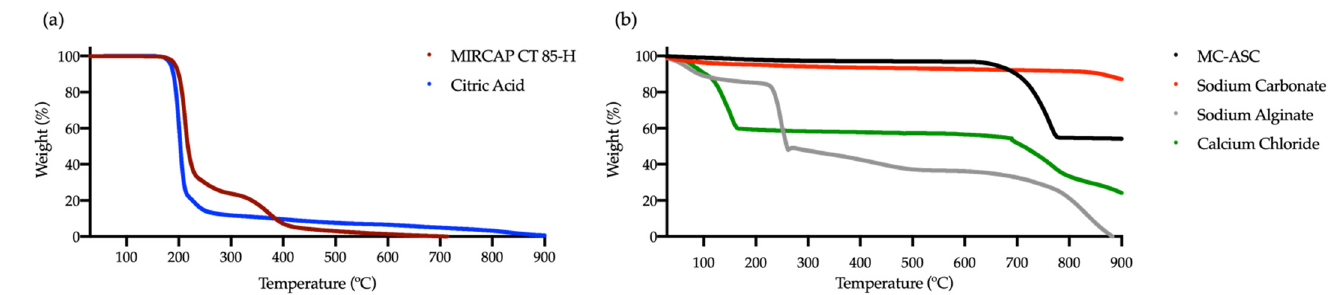
Figure 7. TGA curves of citric acid and hydrogenated palm oil encapsulated citric acid (MIRCAP CP 85 ‐ H) ( a ), and of all compounds used in the synthesis acid neutralizer MC ‐ ASC ( b ).